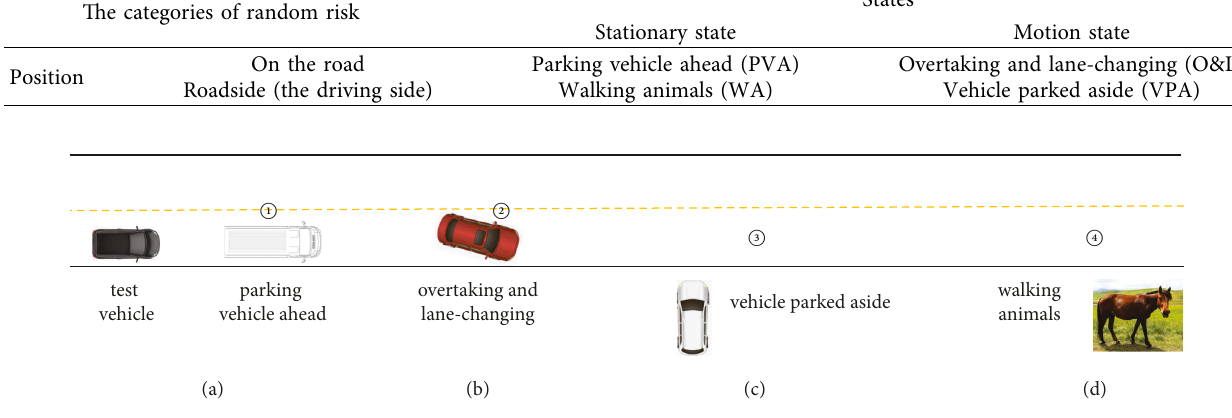
Figure 2: Schematic diagram of driving risk area and driving test